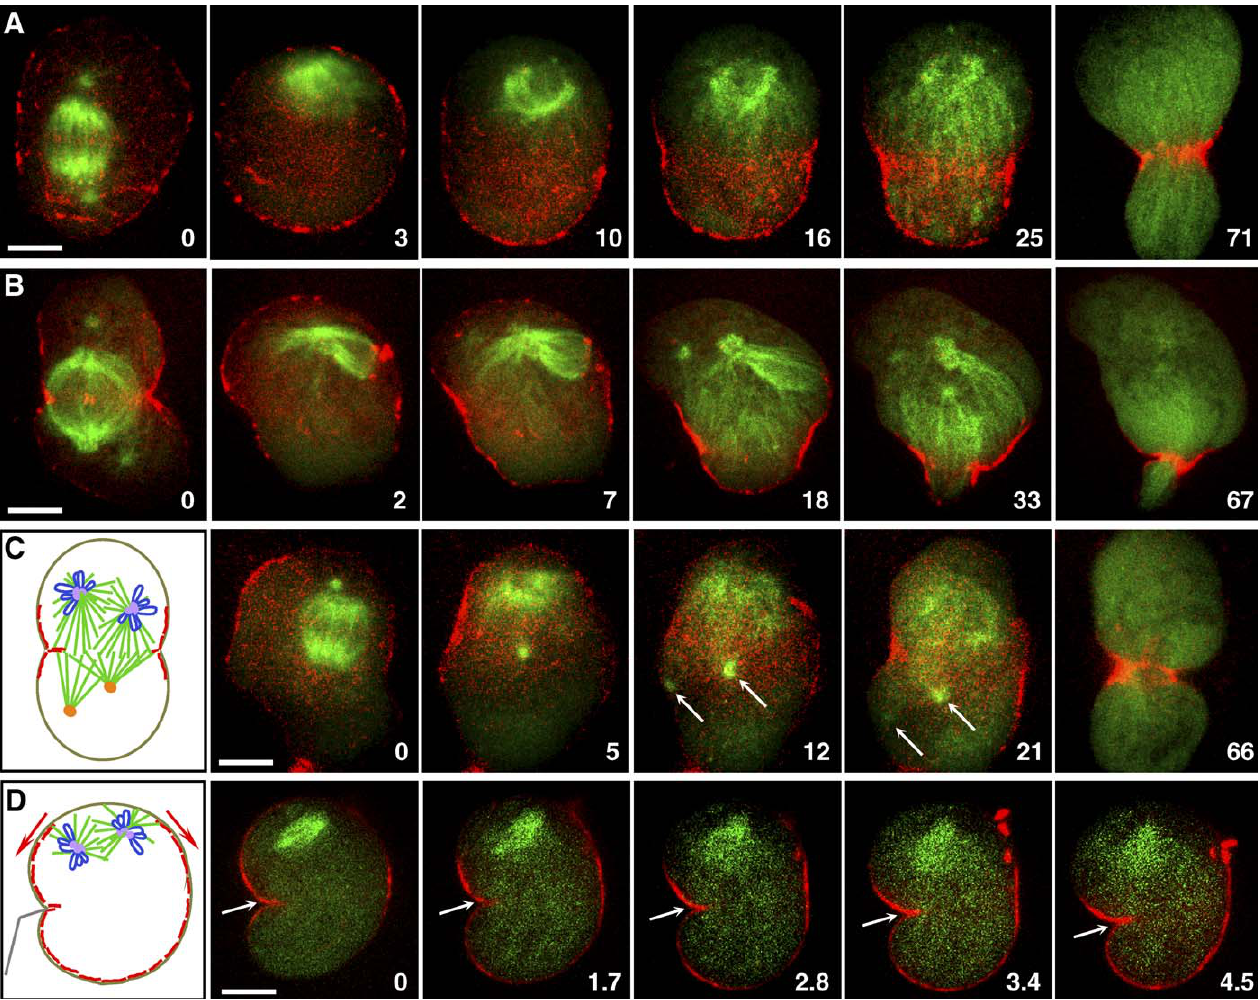
Figure 3. Cortical Flow of Actin Filaments Was Driven by Spindle Microtubules (A) During anaphase (0), when the spindle apparatus was collapsed, and pushed with a microneedle to an arbitrary region of the cell cortex (3), actin filaments flowed to the opposite side of the cell (3–25). This redistribution of actin filaments by spindle microtubules resulted in asymmetric cell division (71). (B) Repositioning and reorganization of the spindle (2) during telophase resulted in a similar scenario, preceded by regression of the original furrow. (C) An anaphase cell (with only one aster visible in this focal plane; 0) was mechanically remodeled by moving spindle microtubules to the upper portion of the cell and collapsing the spindle (shown at top of cell, 5–21). The collapsed spindle was manipulated to detach and relocate first one of its asters (dot in center of cell, 5) and then its second aster (to left of first aster; both asters marked by arrows, 12–21). Possibly due to actin exclusion (5–21) by microtubules from both structures, the contractile ring formed between the collapsed spindle and the pair of detached asters (21–66). This is shown in the schematic diagram (representing the cell in 21). (D) A schematic of the set-up, with fluorescence images of microtubule-driven actin flow blocked by a microneedle. The schematic shows the cell’s outline, the location of the needle (gray), and the direction of flow of cortical actin (red), as induced by the collapsed, repositioned spindle (green, at top). The manipulation needle (arrows), which indented but did not pierce the plasma membrane, locally intercepted the actin flow; brighter fluorescence accumulated on the side of the needle that faced the repositioned spindle (1.7–4.5). The three large red objects (3.4–4.5, upper right) are cell division scars, i.e., remnants from former cytokinetic rings. These scar structures can also move around within the cortex during cortical flow. Note: despite removal of the holding needle, the spindle is not depicted as a giant aster, since the reorganization from monopolar spindle to aster takes at least several minutes. Cells in (A–D) were labeled as in Figure 1B. Time in min. Time 0 in (A), (C), and (D), mid to late anaphase; in (B), telophase. Bars, 10 l but they could not move poleward (unpublished data). cells whose microtubules were simultaneously labeled and However, de novo actin assembly at the midzone of micro- stabilized with Oregon green paclitaxel (Figure 5C and Video tubule plus ends was apparent (Figure 5C, 3–10; insets show S11; n ¼ 11). We determined whether paclitaxel-treated cells the actin channel alone; and Video S11). Emergence and accumulation of actin fluorescence at the spindle midzone with a microneedle—allowing us to assess whether homolo- appeared similar in stabilized and nonstabilized cells (com- gous chromosomes were physically separable or still attached pare to Figure 5A), demonstrating that aggregate assembly to one another. Following the onset of anaphase, chromo- was independent of microtubule dynamics. However, the somes in spindles that were stabilized at the metaphase- assembled actin aggregates remained at the midzone of the anaphase transition could be separated from their homolog,